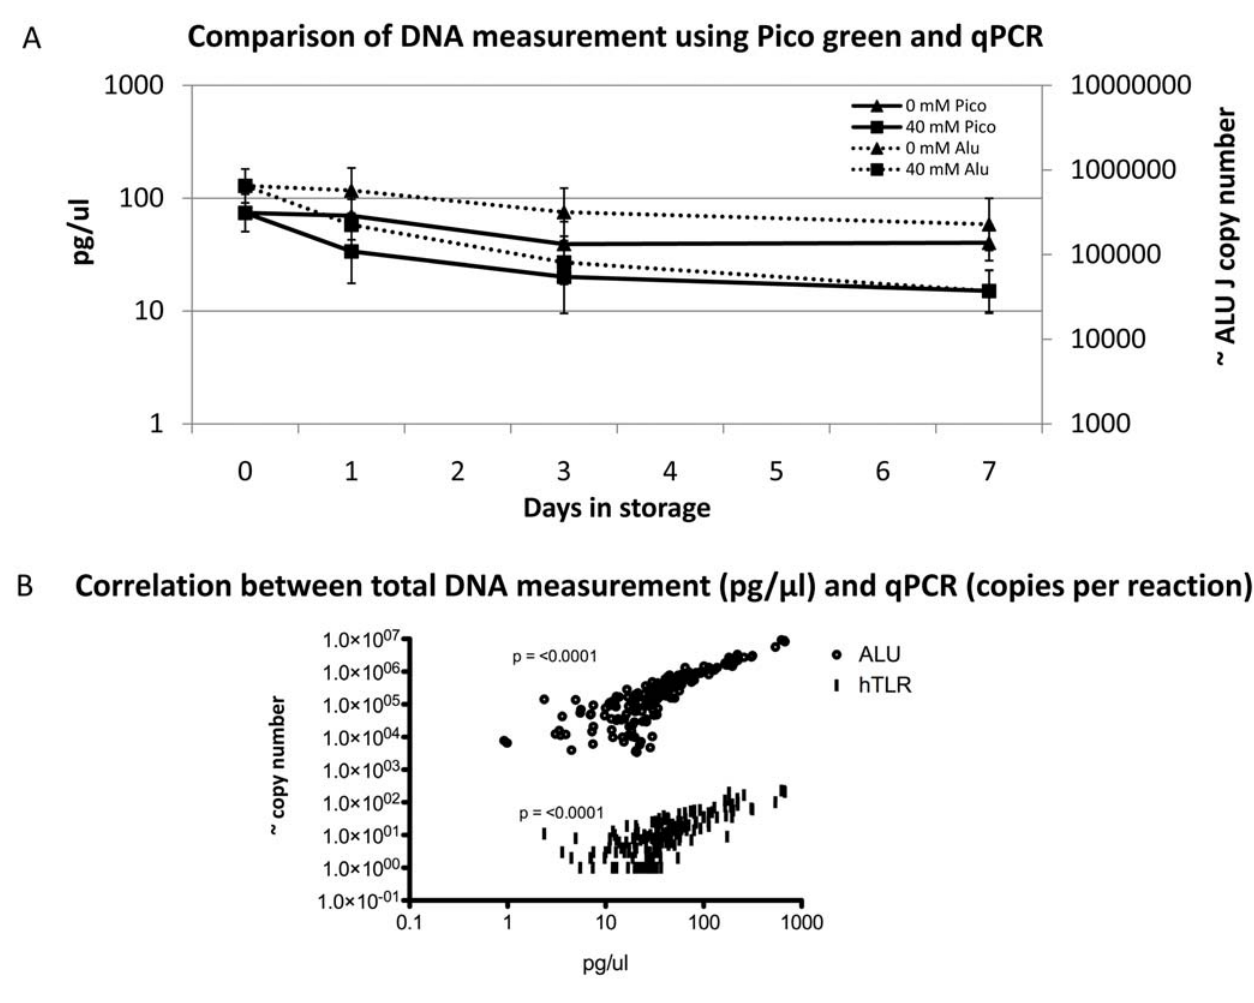
Figure 6. Comparison of DNA measurement using Pico green and qPCR. The stability of human and total DNA in urine stored at 2 20 C with 40 mM EDTA and without EDTA shown the same trends (A). Geometric means + / 2 95% confidence intervals are plotted for each treatment. Measurement with both human qPCR targets correlate with the direct measurement of total nucleic acids using pico-green (B). QPCR using these targets is an appropriate surrogate measure for total DNA and has a greater dynamic range than pico-green for which the lower threshold for accurate measurements is approximately 10 pg/ m l.